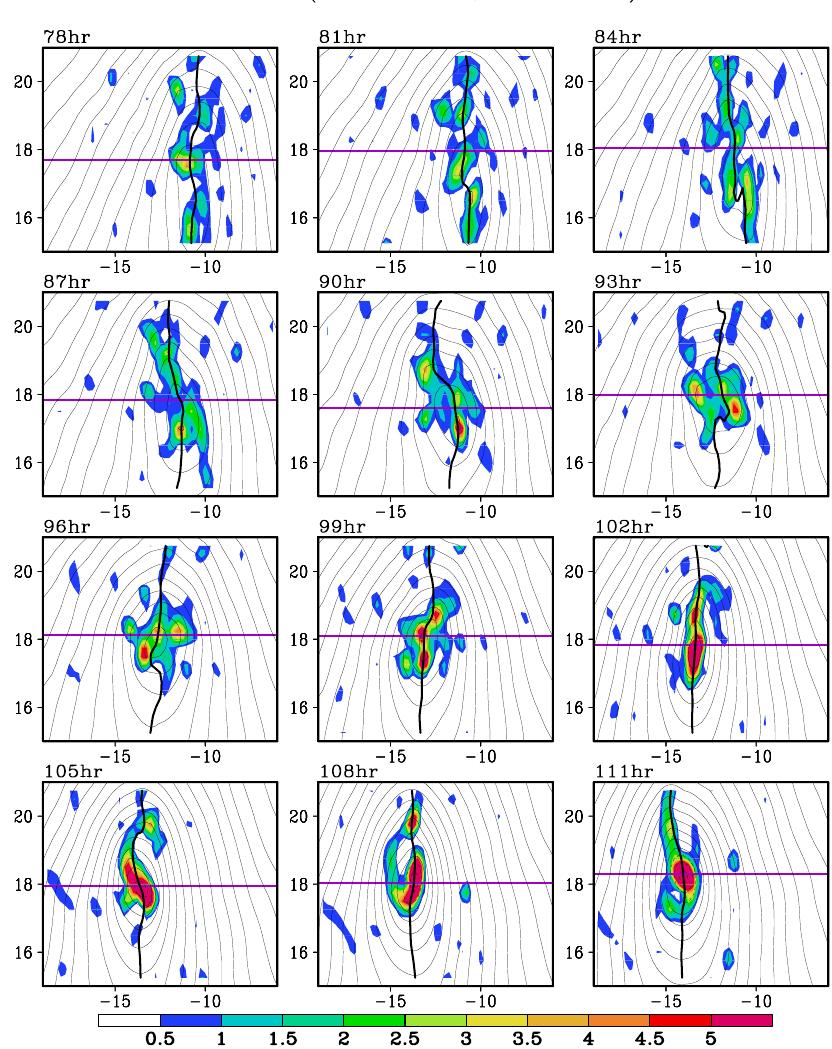
Fig. 8. Evolution of stream function and relative vorticity (color) in the coarse-resolution (control) run from hour 78 to hour 111 in the co-moving frame of reference that moves at the zonal speed of the parent easterly wave. The units of the vorticity are 10 − 4 s − 1 . The black curve is the wave trough axis and the purple line indicates the (linear) critical latitude (see text for details). The ordinate is latitude and the abscissa is longitude.